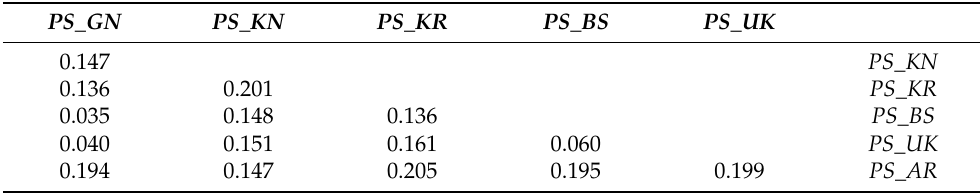
Table 6. Pairwise genetic distances ( D N ) between the populations studied of P. sylvestris .